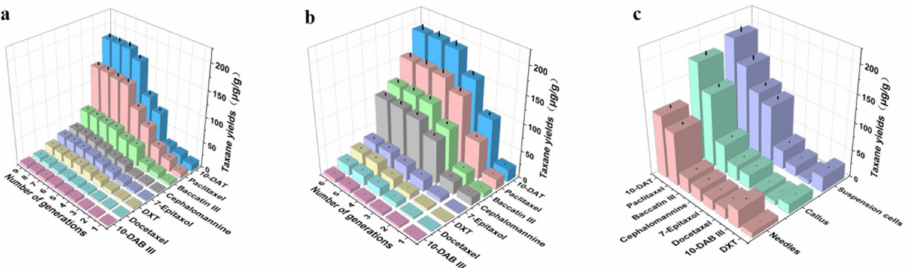
Figure 7. Comparison of taxane yields in the needles, callus, and suspension cell extracts of Taxus cuspidata : ( a ) the effect of different subculture cycles of callus on taxane yields, ( b ) the effect of different subculture cycles of suspension cells on taxane yields, ( c ) comparative graph of taxane yields in needles, callus, and suspension cells ( p <